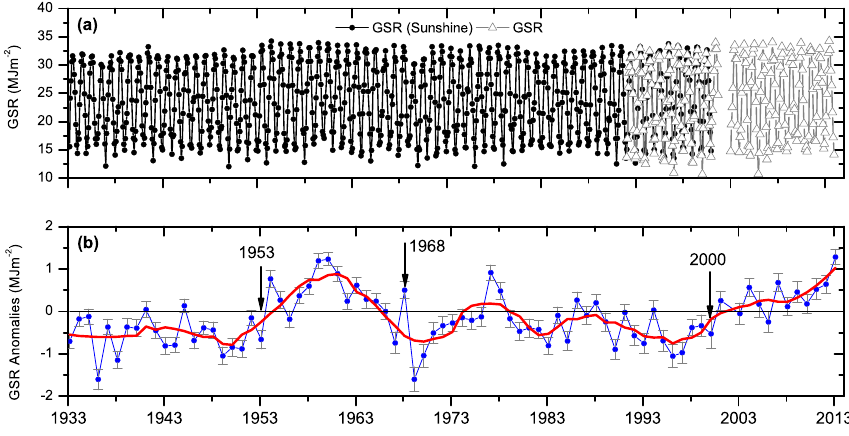
Figure 6. (a) Time series of the GSR (MJm − 2 ) monthly means. The black dots represent the GSR obtained from SD data and the grey triangles represent the GSR measured between 1992 and 2000. (b) Annual means of the GSR anomalies. The arrows indicate the change-point dates. The error bars indicate ± 1SEM (standard error of the mean). Five-year moving average is shown in red.